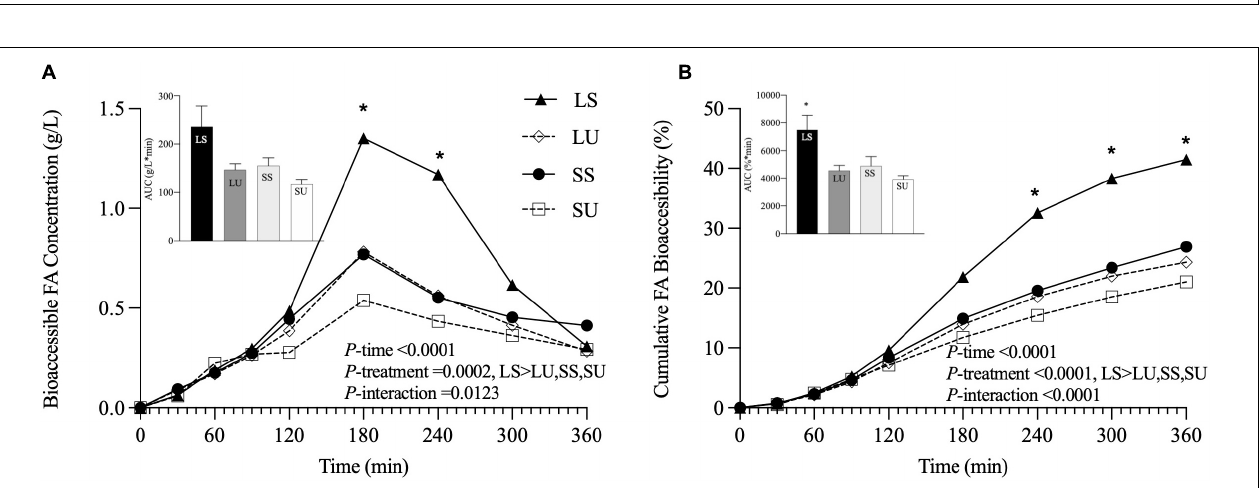
FIGURE 6 | Line graphs representing bioaccessible FA concentration (g/L) (A) and cumulative FA bioaccessibility (%) (B) over time, with inset bar graphs showing AUC of LS, LU, SS, and SU during 6-h in vitro TIM-1 digestion ( n ≥ 3). Data reported as mean ± SEM. Asterisk indicates a significant difference between LS and all other emulsions, p < 0.05. LS, liquid lipid-acid stable emulsifier; LU, liquid lipid-acid unstable emulsifier; SS, solid lipid-acid stable emulsifier; SU, solid lipid-acid unstable emulsifier; FA, fatty acid; AUC, area under the curve.